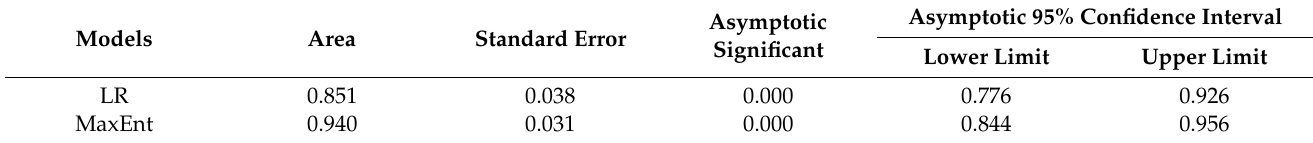
Table 6. Area under the curve (AUC) values of the